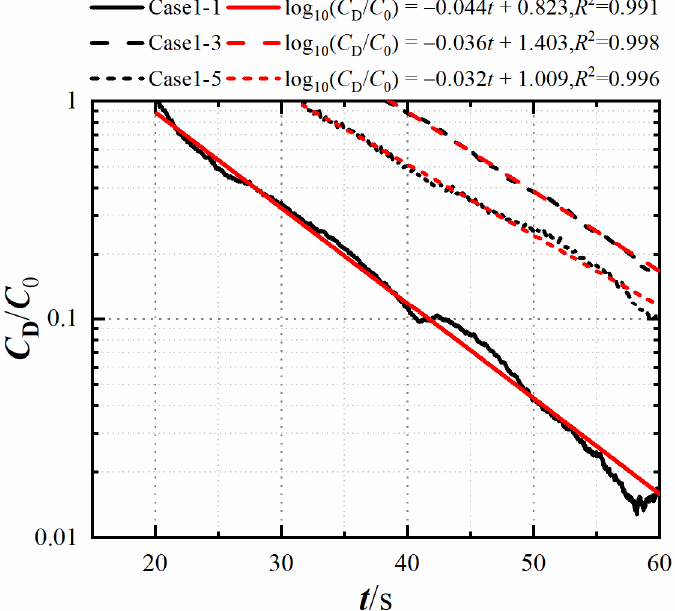
Figure 7. Time-history curve of the average concentration of inorganic salt released in the groin field without vegetation.